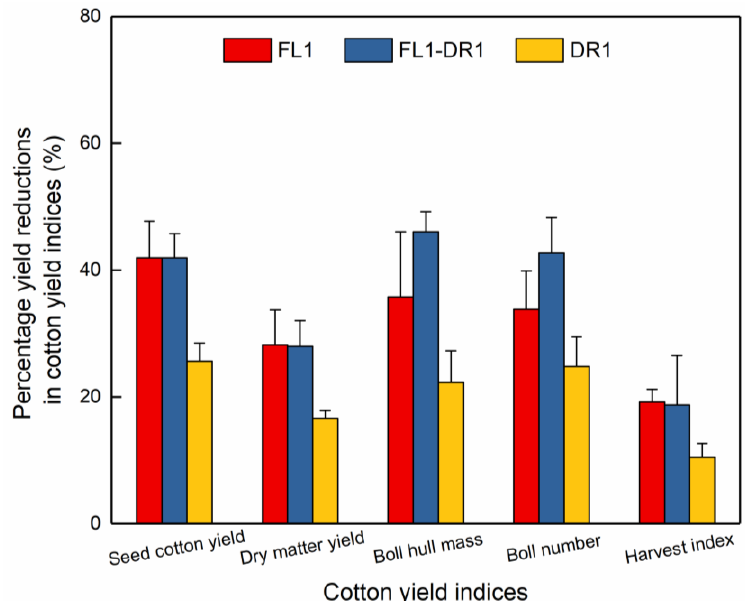
Figure 5. The percentage reductions in cotton yield indices under flood followed by drought, flood alone, and drought alone. ‘FL1’, ‘FL1-DR1’, and ‘DR1’ represent the treatments of five-day flood alone, five-day flood followed by 10-day drought, and 10-day drought alone, respectively. Error bars indicate standard errors.